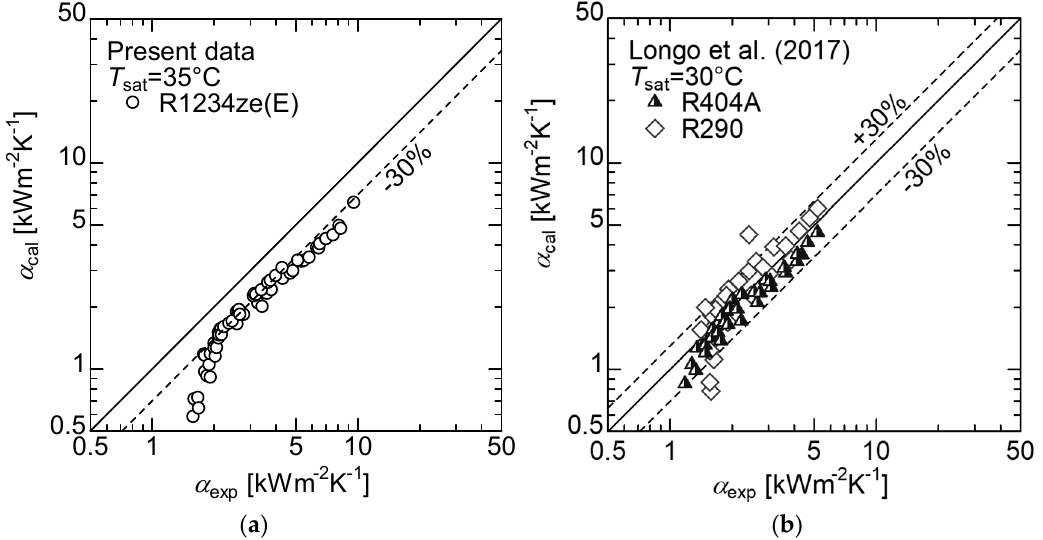
Figure 8. ( a ) Comparison of the heat transfer coefficient between that predicted by the present correlation, and the measured values of R1234ze(E). ( b ) Comparison of heat transfer coefficient between that predicted by present correlation, and data from Longo at al. for R404A and R290.